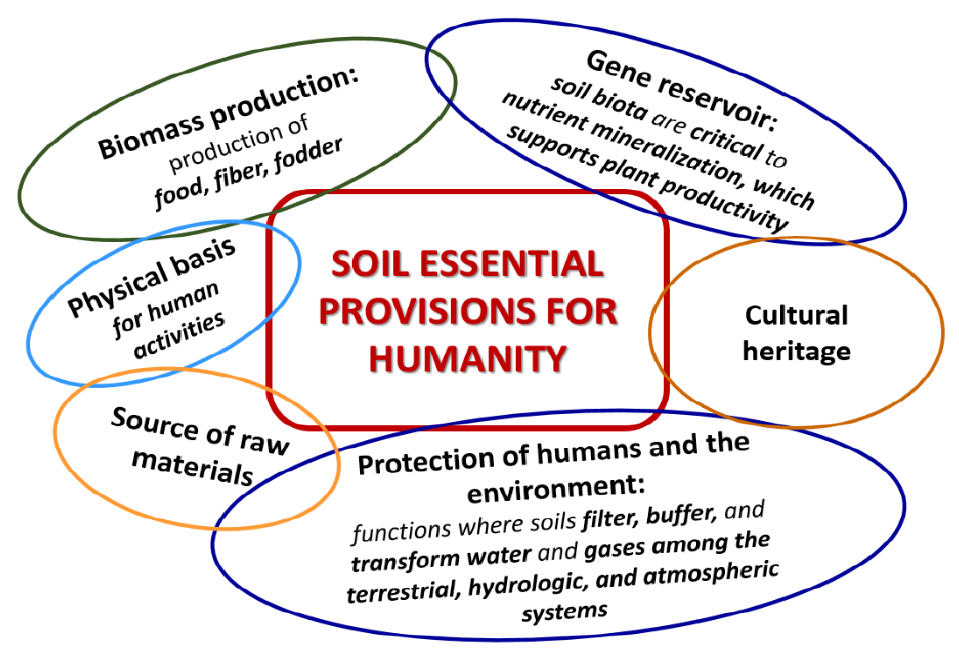
Figure 5. The essential role of soil in providing humanity support for life.